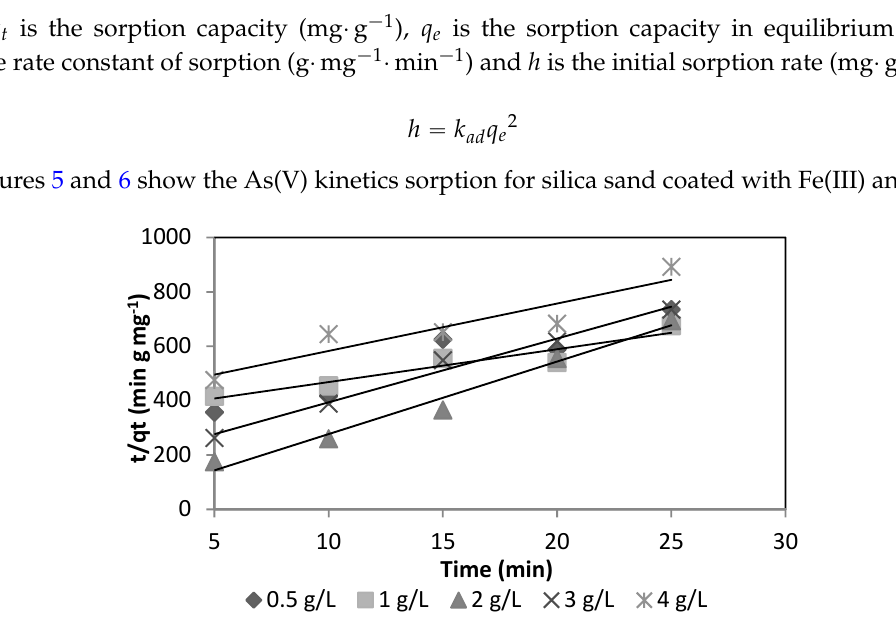
Figure 4. FTIR spectrum of goethite in absence and presence of As(V).